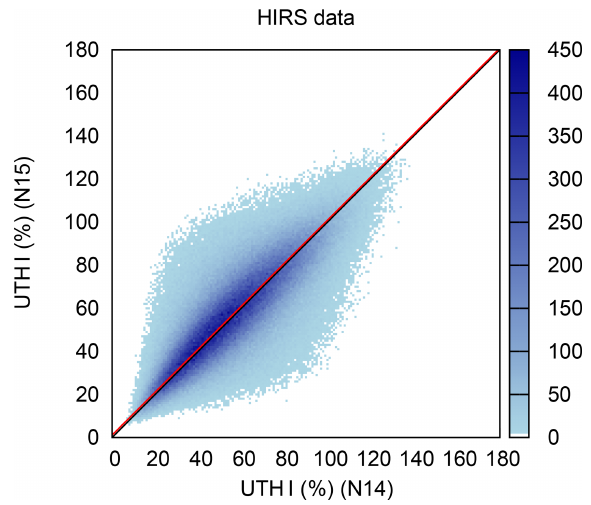
Figure 8. Heat map of UTHi from NOAA-15 vs. UTHi from NOAA-14 for 1004 common days of operation. The corresponding brightness temperatures have been transformed into UTHi using the second-order retrieval formulae derived in this paper. More details are given in the main text. Evidently the data pairs are nicely spread out along the diagonal line and there is not the same deviation from the diagonal in the upper UTHi range as before. The red line repre- sents the bivariate regression between the two data sets. It is almost identical to the black